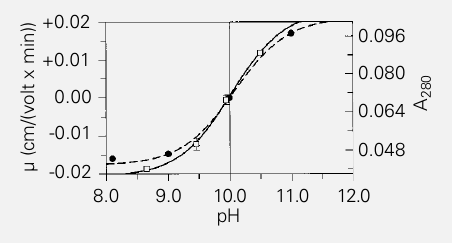
Figure 1 - Determination of ß- trypsin isoelectric point. The continuous line represents the best fit to the data (open squares) for the isoelectric point determination by protein bind- ing to SP-Sephadex C-50 gel (A 280 ) vs pH. The pH value at which 50% of the protein is bound to the gel corresponds to a pI value of 10.03 ± 0.08. The discontinuous line (filled circles) represents the best fit for the migration (µ) in cm/(volt x min). The migration equal to zero was obtained at pH 10.08 ±